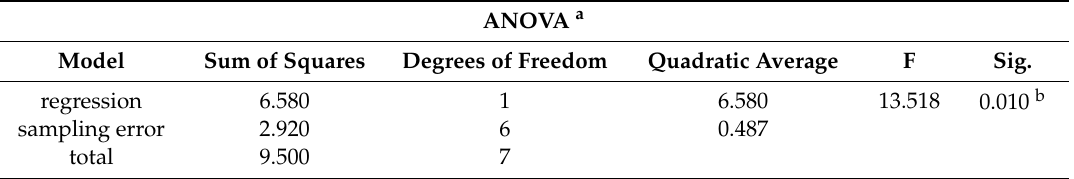
Table 10. Analysis of variance: Wheel-tracking test and topographic settlement.